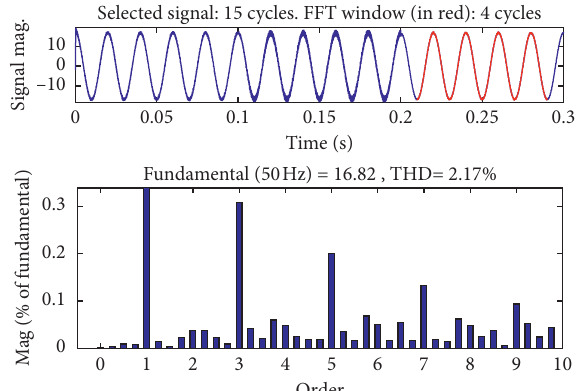
Figure 11: Grid-connected current when RBF optimizes parameters. Selected signal: 15 cycles. FFT window (in red): 4 cycles